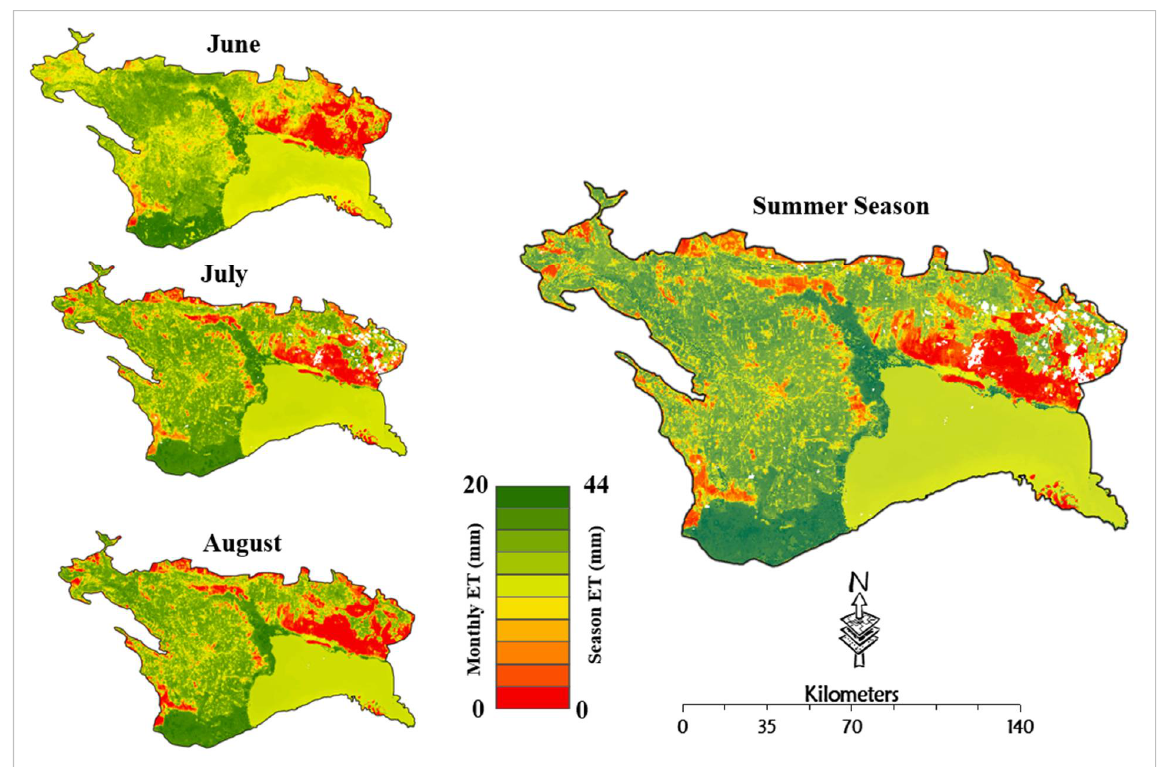
Figure 12. Monthly and season spatial distribution of SEBAL derived ETa variability across the Yanqi basin.